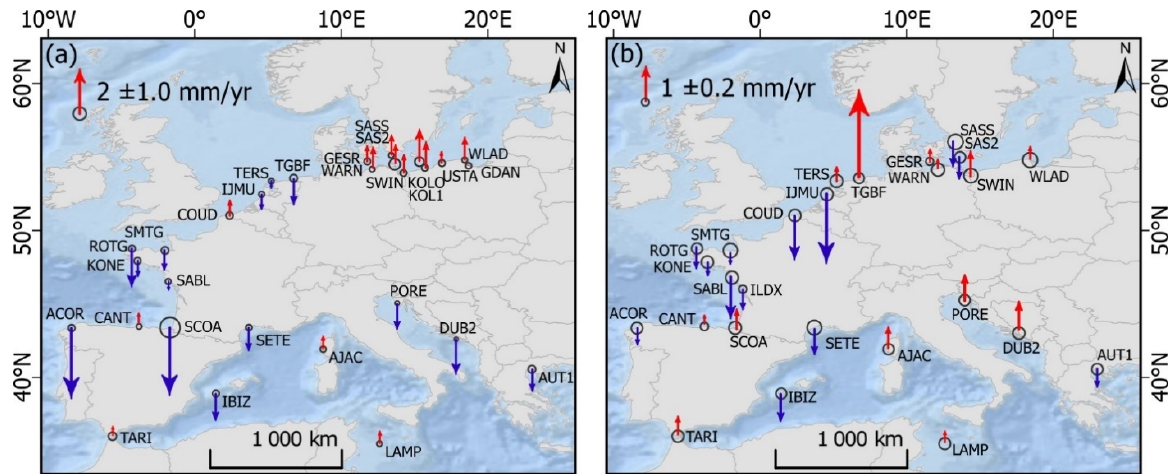
Figure 14. ( a ) Map of vertical crust movement in coastal stations estimated from different time series of GNSS data. GNSS data were acquired from 27 GNSS stations which are colocated with or positioned in the proximity of a TG station on the European coast. ( b ) Map of vertical motion based on multitime SAR data series for 2015–2017; the units on both pictures are in mm/year. The linear trend standard errors are visualized by black circles. Positive values of the linear trend are visualized by a red arrow. Negative values of the linear trend are visualized by a blue arrow.